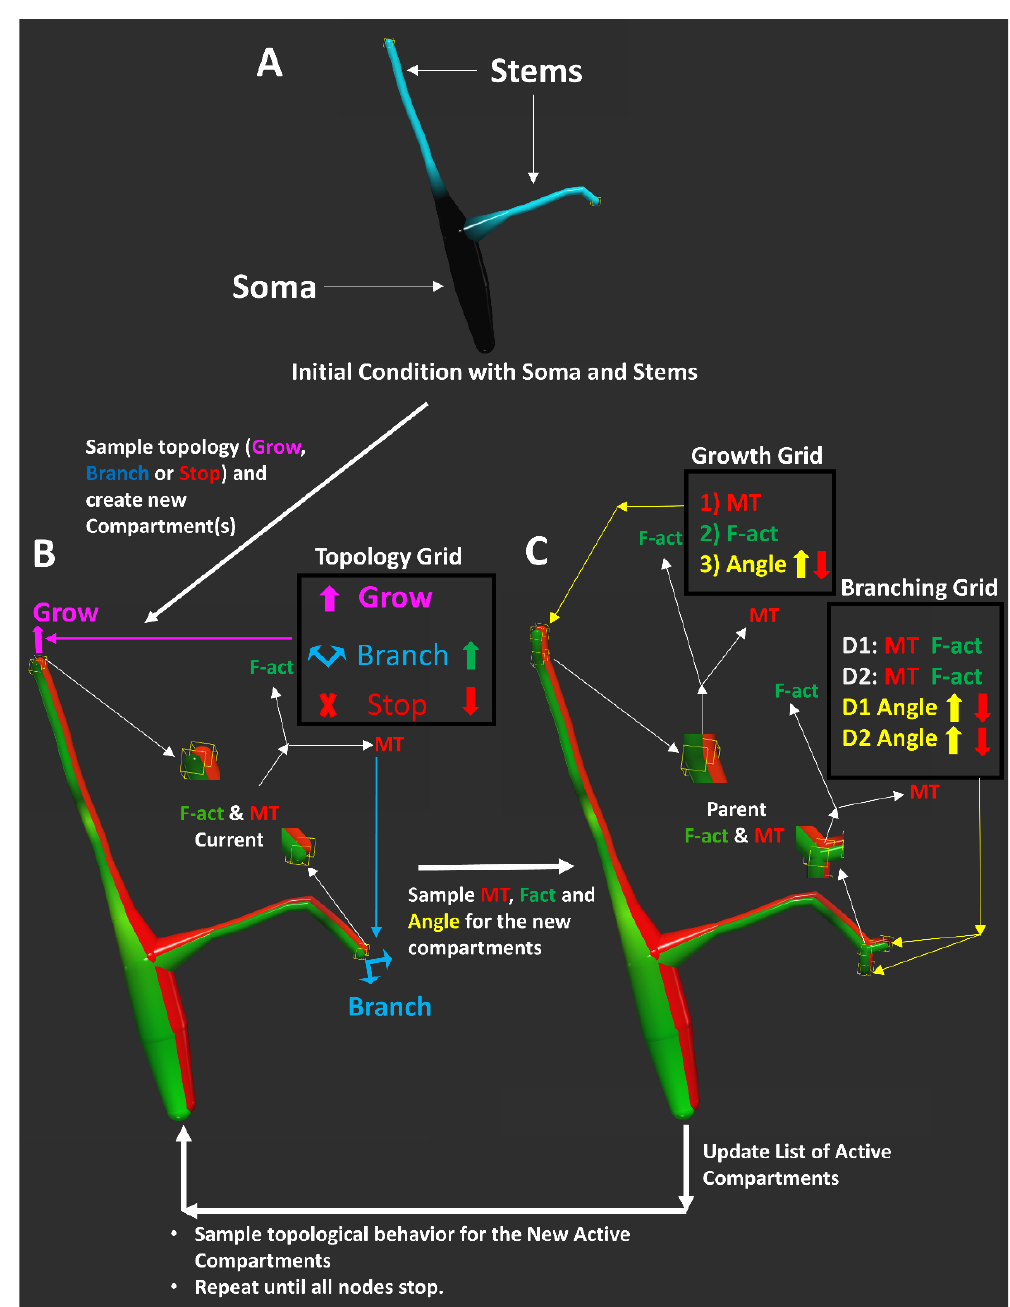
Figure 4. Computational Model of Dendritic Morphology. ( A ) The tree generation process starts with the initial MT and F-actin concentration of the soma and the dendritic stem end points as active compartments. ( B ) For each active compartment, the event sampling determines whether to grow (adding one new compartment), branch (adding two new compartments), or stop (ending the branch). Enriched F-actin (upward green arrow) increases branching probability. Reduced microtubules (downward red arrow) increase termination (Stop) probability. ( C ) If a node grows or branches, the cytoskeletal composition of the newly created compartment is sampled from the corresponding data grids along with their angular deviations relative to their parent compartments. Reduced microtubule (downward red arrow) leads to increased angular deviation (upward yellow arrow). The process is repeated for all newly added compartments, until all branches stop.